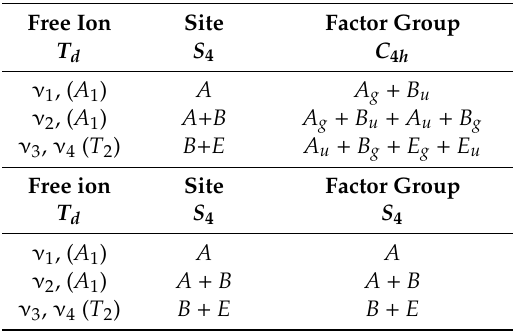
Table 5. Correlation diagram for the MoO 4 tetrahedra in structures with C 4 h and S 4